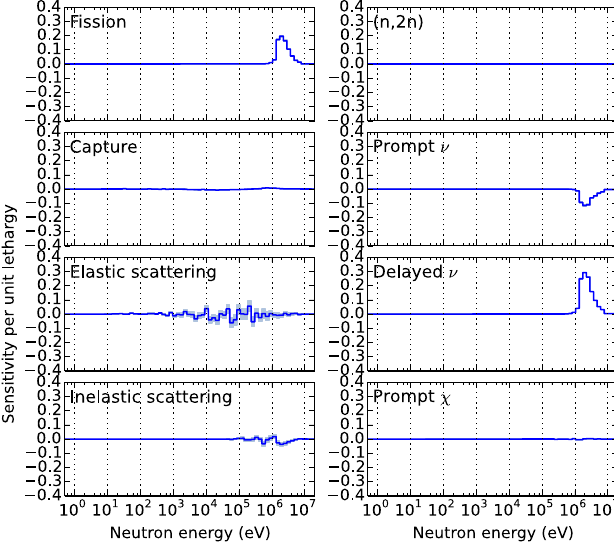
Fig. 7. 238 U sensitivity pro fi le for the critical core ( a =